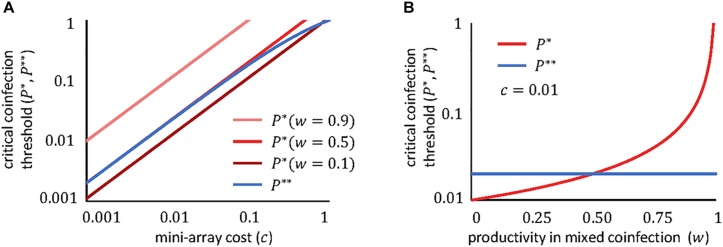
Dependency of the critical coinfection thresholds P∗ (red) and P∗∗ (blue) on the cost of the mini-CRISPR array c
(A) and on the viral productivity in mixed coinfections w
(B). We fixed q = 1/2, which is appropriate if both viruses are equally likely to enter the cell first. If both viruses obtain even yields in mixed confections, w = 1/2 corresponds to the case where viruses do not interfere with each other; w < 1/2 if there is interference; and w > 1/2 if there is facilitation. Note the logarithmic scale of the axes.